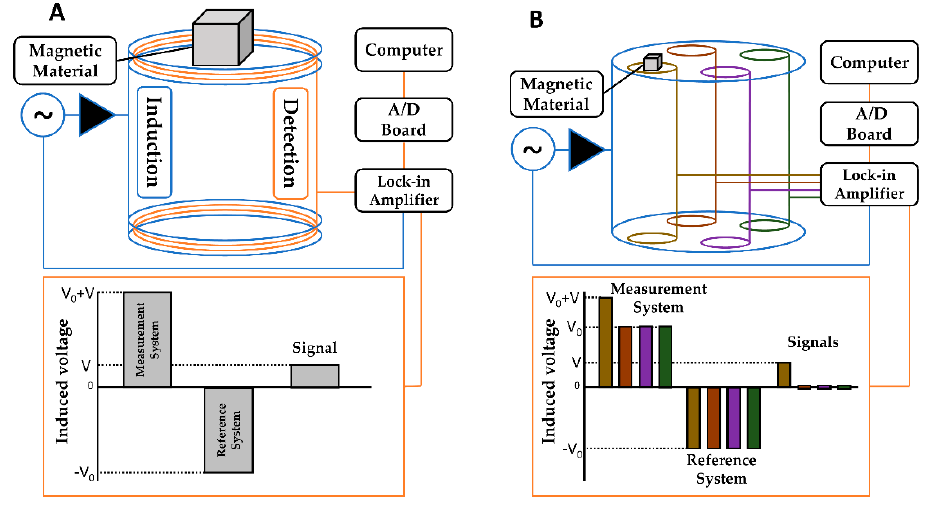
Figure 1. Functional diagram of the ACB setup and its principle of operation. ( A ) Schematic representation of the SC-ACB and ( B ) Schematic representation of MC-ACB with multiple detection coils.